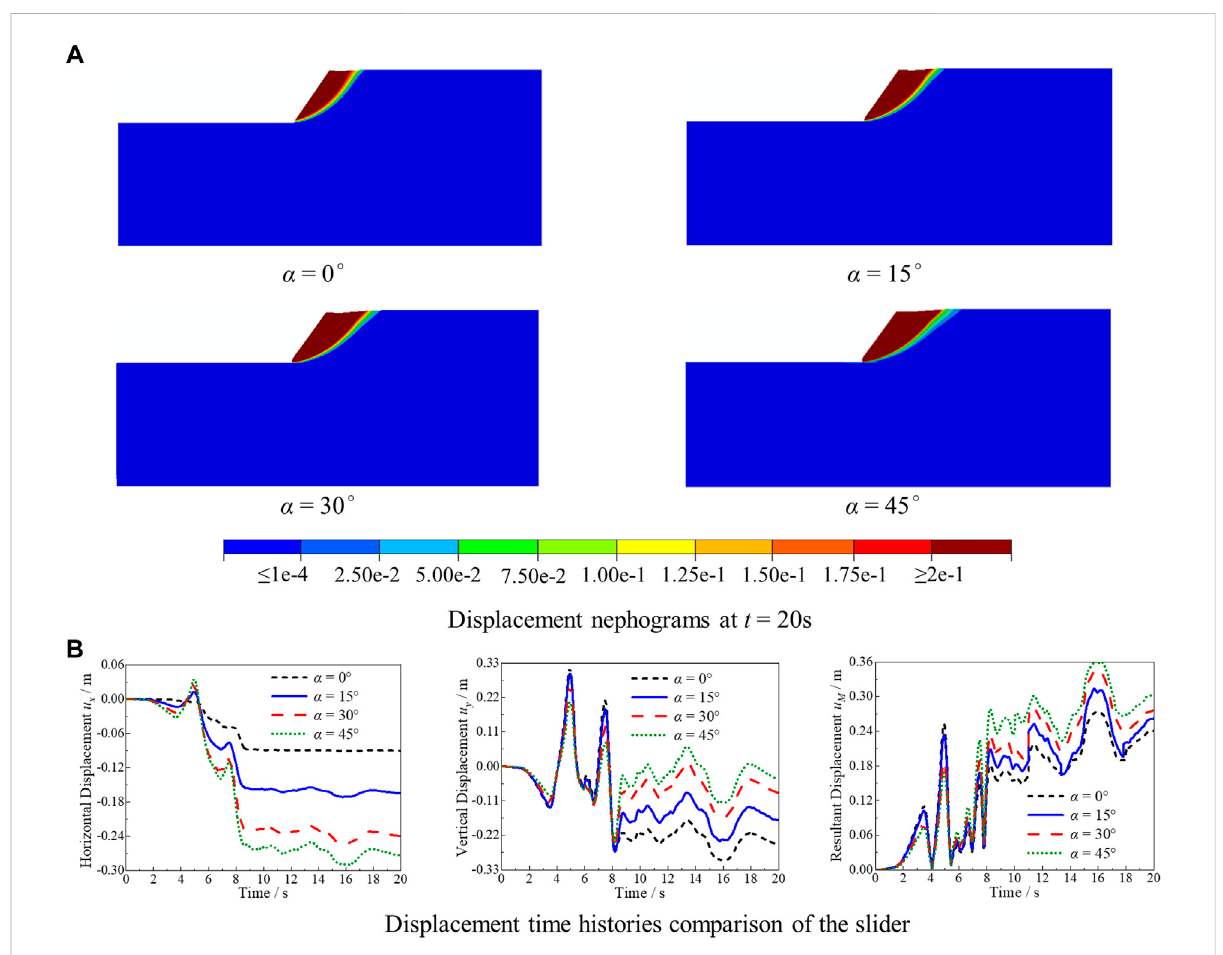
FIGURE 9 Displacement of the slope at different incident angles. (A) Displacement nephograms at t = 20 s. (B) Displacement time history comparison of the